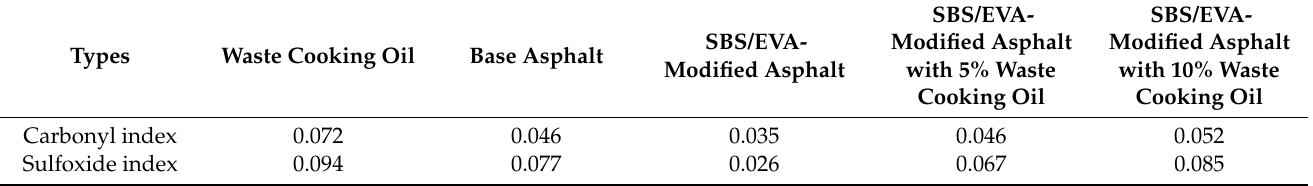
Table 7. Results of sulfoxide index and carbonyl index